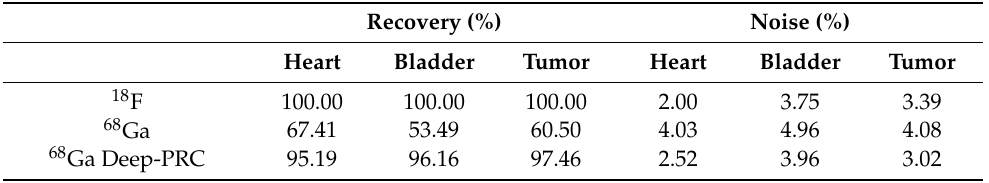
Table 2. Quantitative analysis of the results over different